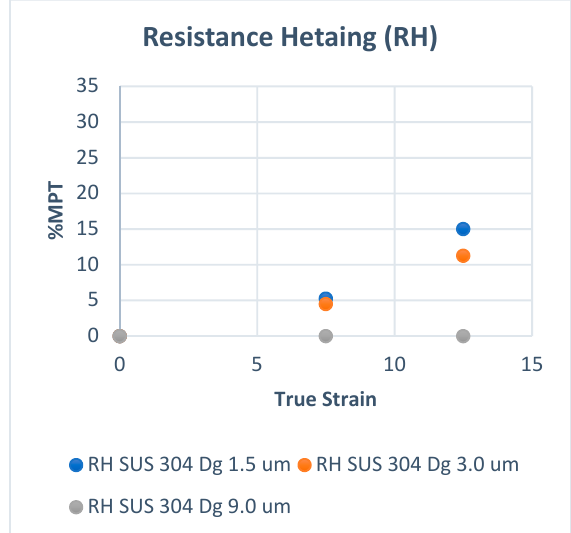
Figure 3. MPT at elevated temperatures.